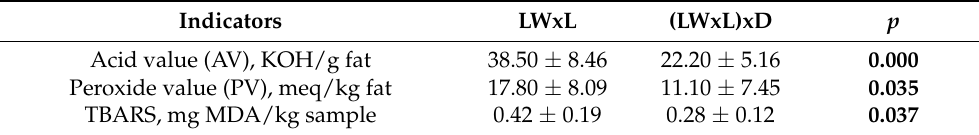
Table 6. Differences between pig genotypes in the indicators of lipolysis and lipid oxidation (means ± standard error) of matured Istarski pršut . Indicators LWxL (LWxL)xD p Acid value (AV), KOH/g fat 38.50 ±